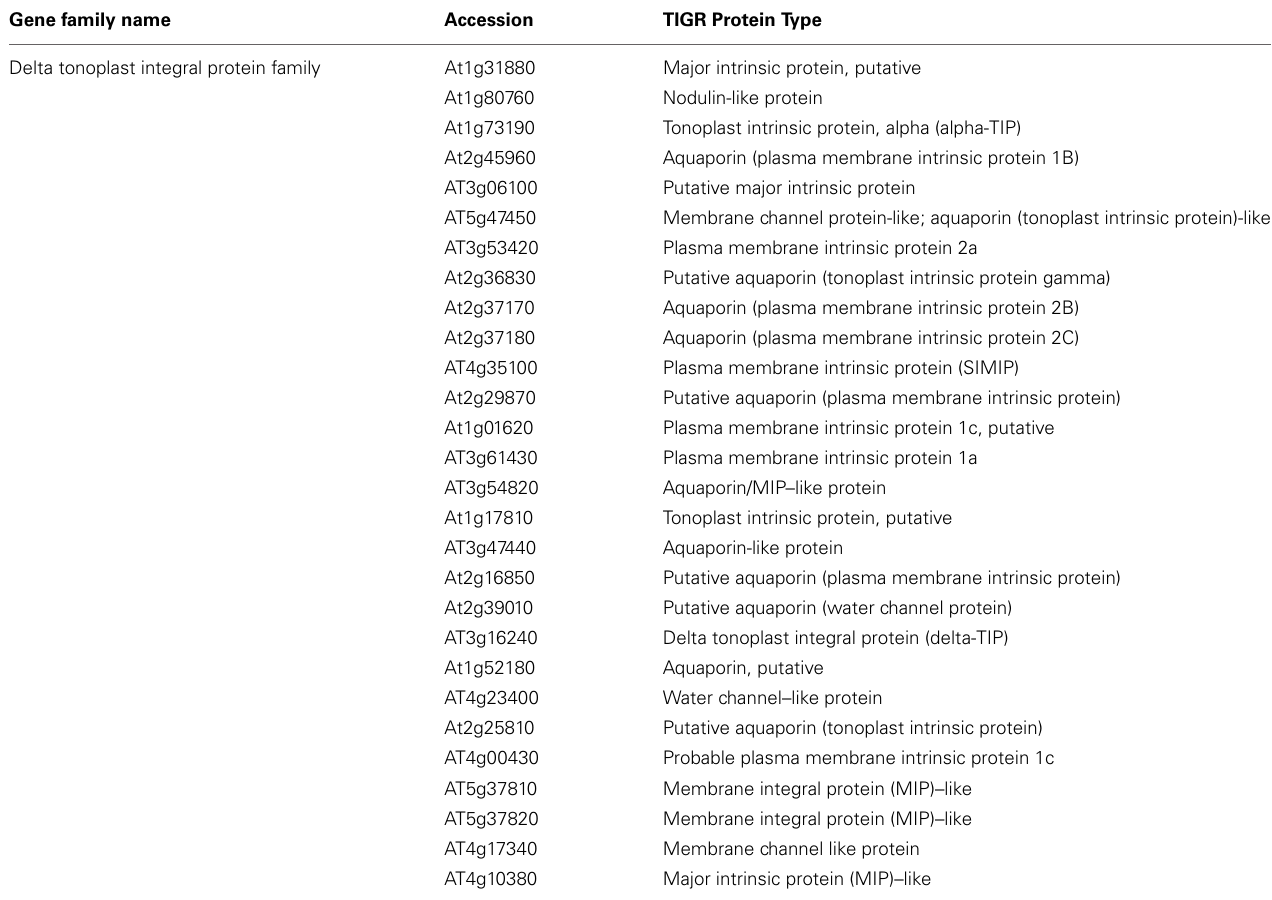
Table 1B | The entire aquaporin family in Arabidopsis extracted from